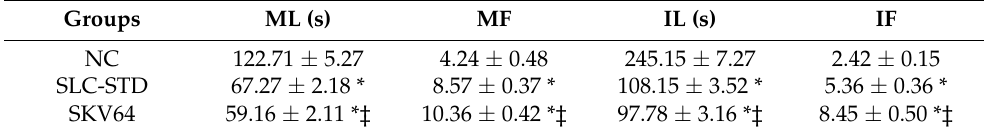
Table 2. Effect of SLC-KV64 on the mount latency (ML), mount frequency (MF), intromission latency (IL), intromission frequency (IF), and copulatory efficiency (CE) of male rats.